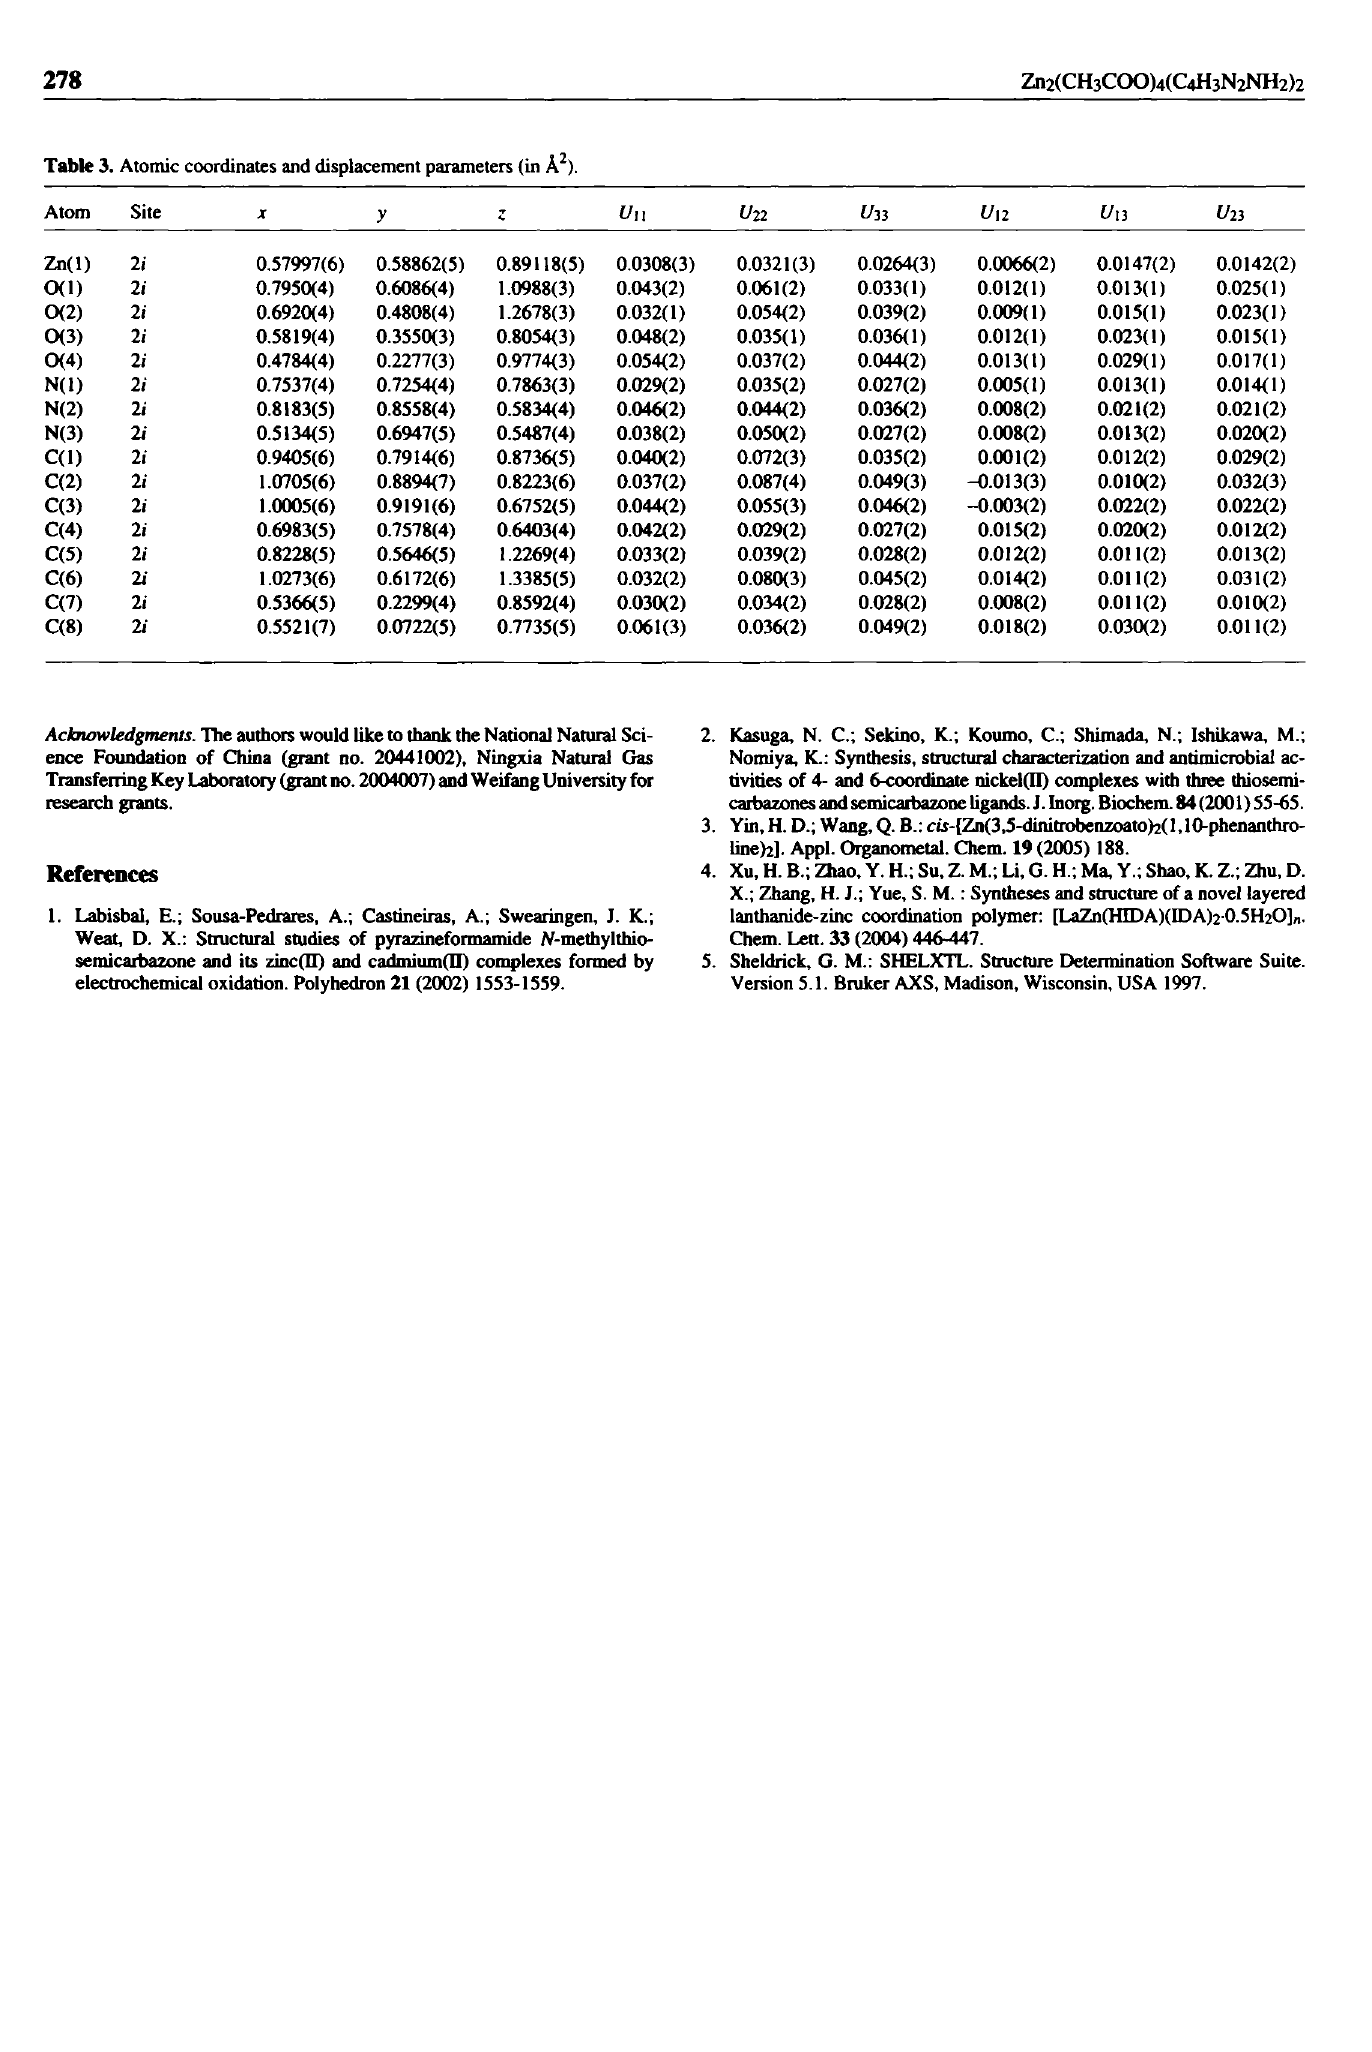
Table 3. Atomic coordinates and displacement parameters (in A 2